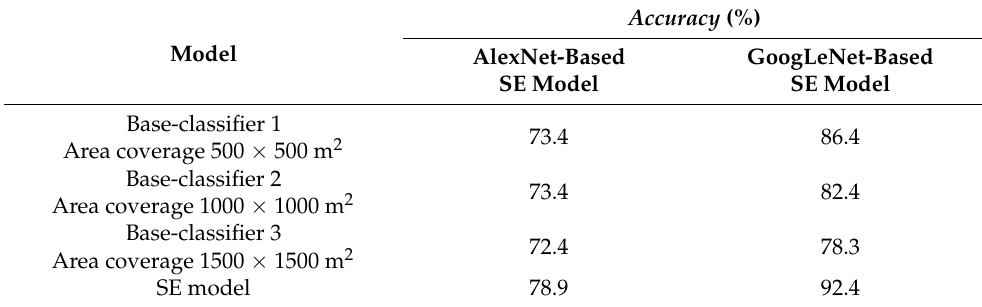
Table 2. Classification accuracies of the AlexNet-based and GoogLeNet-based base-classifiers and stacking ensemble (SE) models for test data.